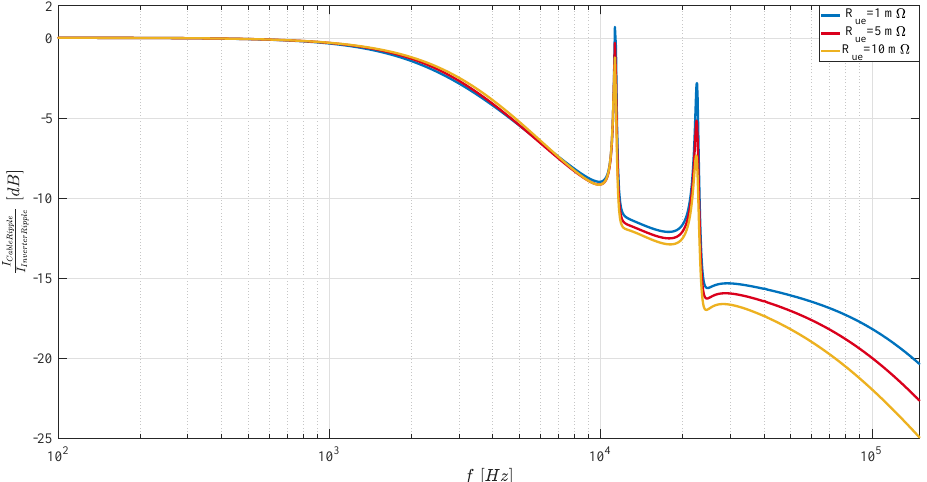
Figure 9. Proportion of cable core ripple and inverter ripple currents in the function of frequency with three different contact